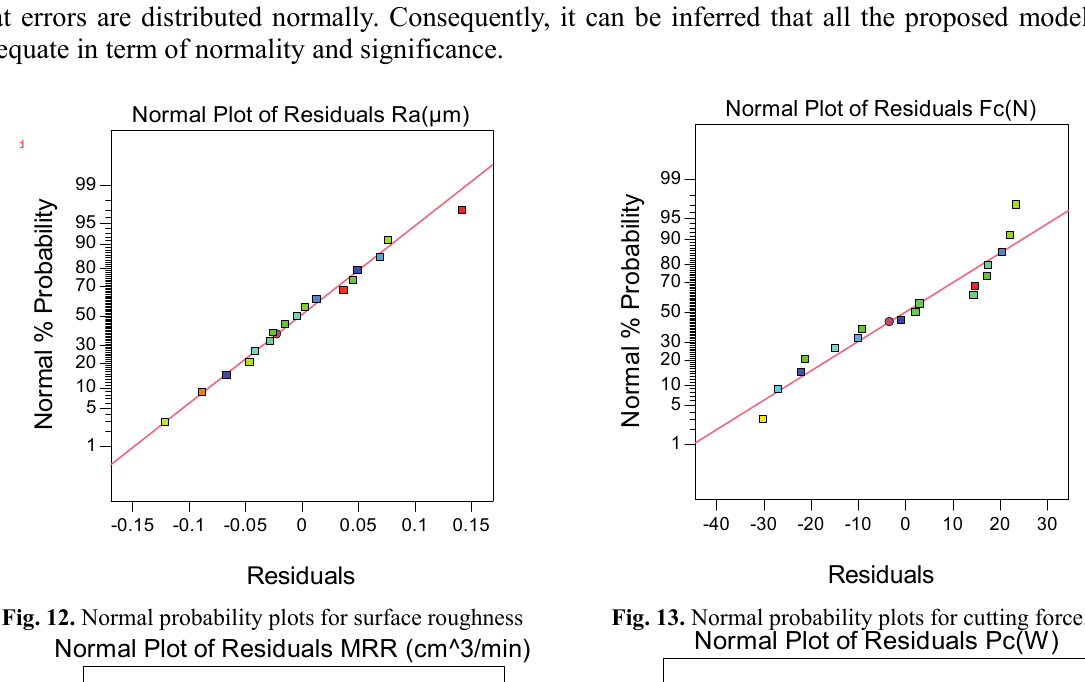
Fig. 10. Comparison between measured and predicted values for material removal rate